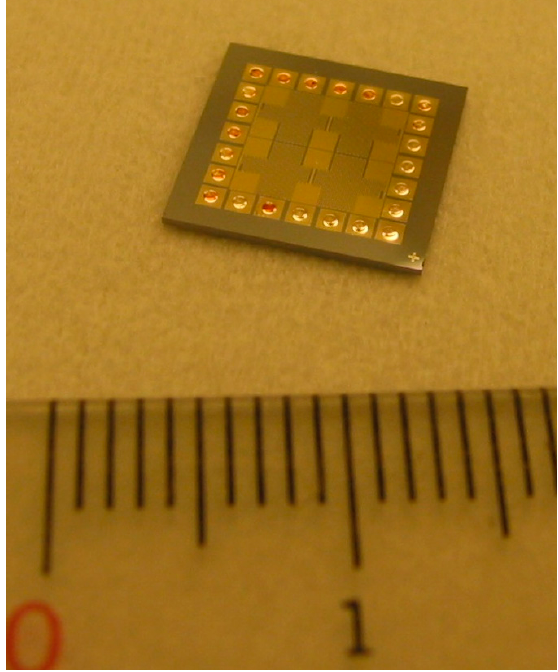
Figure 1. The thermal test chip with resistance thermometers and heating elements.